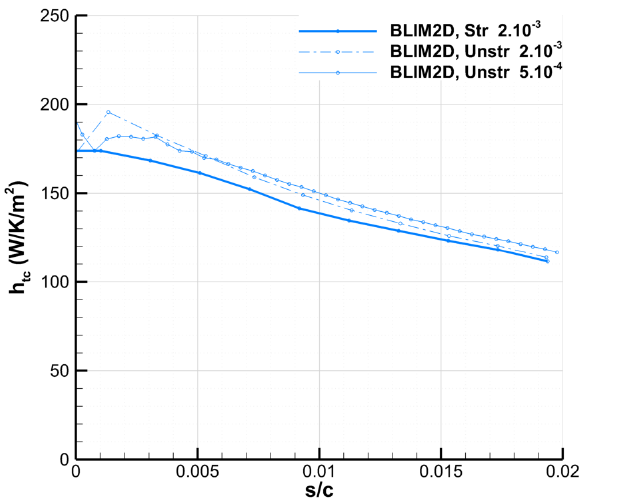
Figure A4. Solution produced by BLIM2D for the heat transfer coefficient in the laminar area of Han and Palacios’s experiment for several